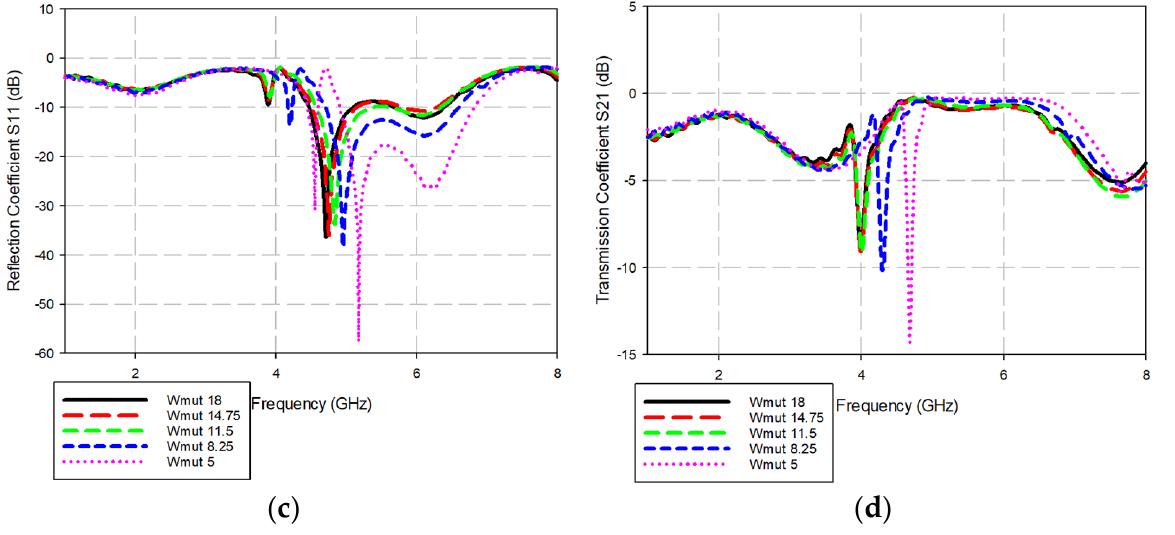
Figure 19. ( a ) Re fl ection coe ffi cient S11 of di ff erent thicknesses of MUT, ( b ) transmission coe ffi cient S21 of di ff erent thicknesses of MUT. ( c ) Re fl ection coe ffi cient S11 of di ff erent widths of MUT, ( d ) transmission coe ffi cient S21 of di ff erent widths of MUT.